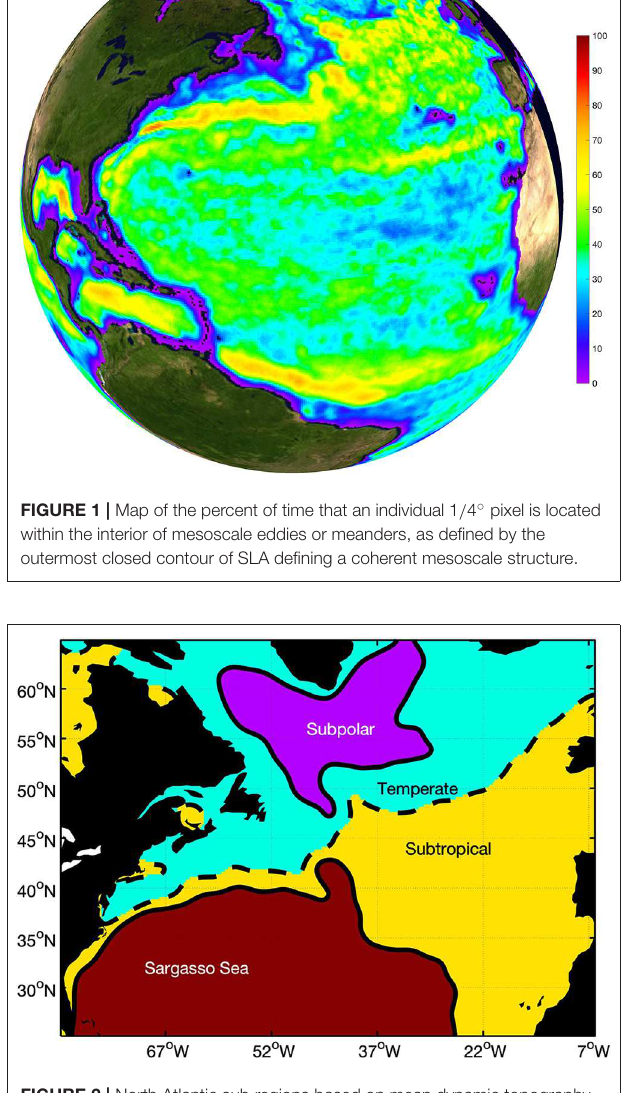
FIGURE 2 | North Atlantic sub regions based on mean dynamic